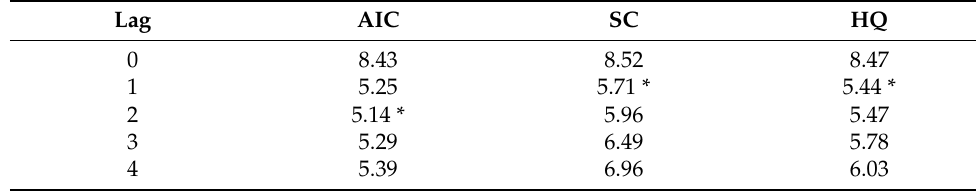
Table 8. VAR lag order selection